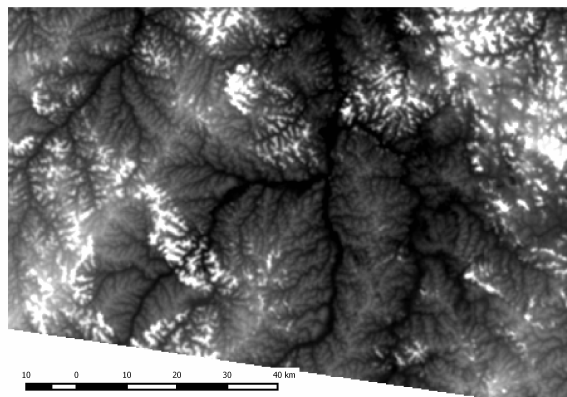
Figure 8: Digital model elevation used as explanatory variable